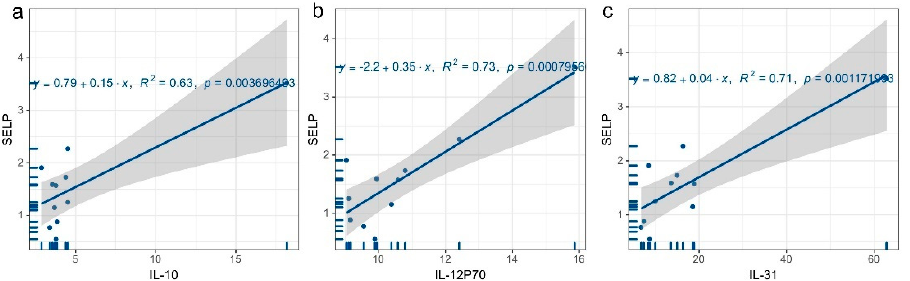
Figure 9. Regression plots of SELP and inflammatory factor levels. ( a ) Regression plots of SELP and IL-10 levels, ( b ) regression plots of SELP and IL-12P70 levels, ( c ) regression plots of SELP and IL-31 levels.